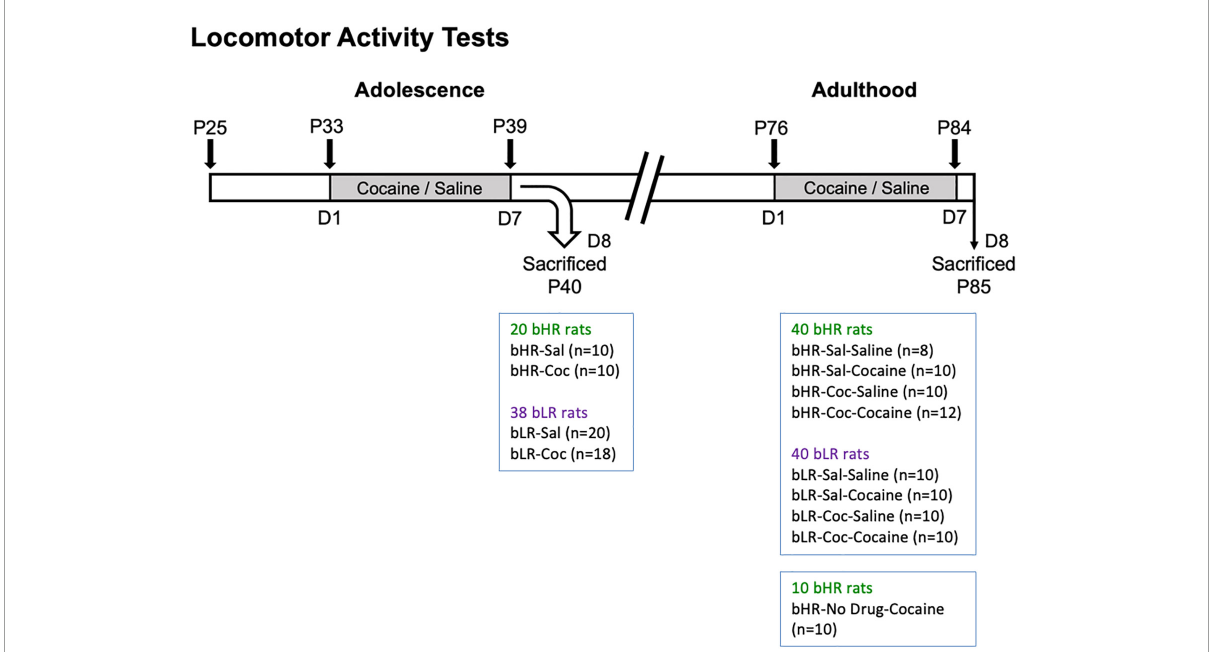
FIGURE1 Drug treatments and psychomotor activating effects of cocaine. Locomotor Activity Tests. P: post-natal day; Gray: drug treatment period. bHR and bLR rats were initially tested for locomotor exploration of a novel environment (P25, Supplementary Figure 1 ). bHRs and bLRs were then assigned to different treatment conditions where either saline or cocaine was administered in adolescence (P33-39), adulthood (P76-84), or both. A subset of these bHRs and bLRs were sacrificed 24 h (D8, P40) following the adolescent cocaine sensitization regimen to assess epigenetic changes at this timepoint. All other conditions were exposed to the second regimen of either saline or cocaine later in adulthood (P76-P84) and subsequently sacrificed